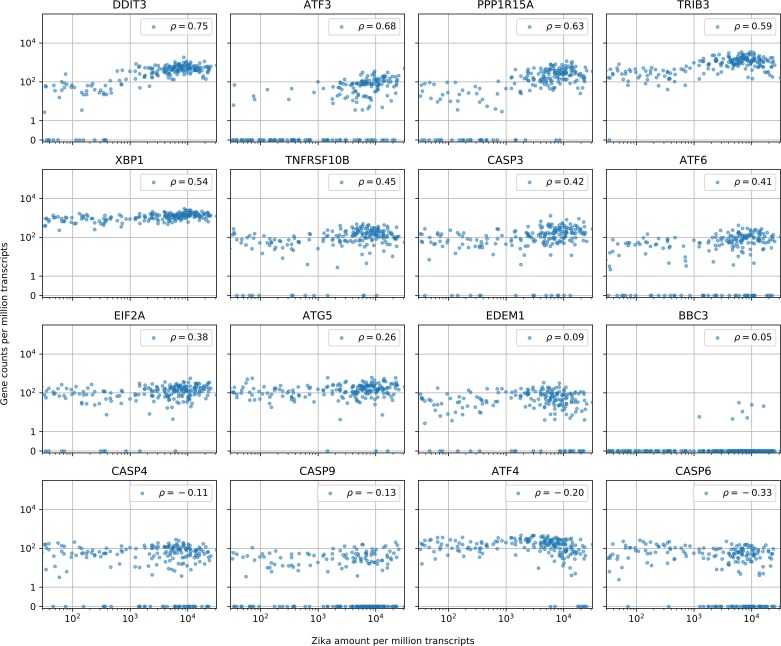
Cells with the highest intracellular ZIKV amounts show ER stress response, increased CASP3 and reduced ATF4 expression.Similar to Figure 3—figure supplement 1 (which is for DENV). In cells with more than 10 Zika virus reads per million transcripts, expression of caspases is not correlated with intracellular virus amount with the exception of CASP3 (positive correlation, unlike for DENV) and CASP6 (negative correlation, like for DENV). A major difference between the two viruses is the expression of ATF4 and EDEM1, the other ER stress response genes behaving in a similar manner for both viruses. Genes are sorted by correlation with intracellular ZIKV amount.